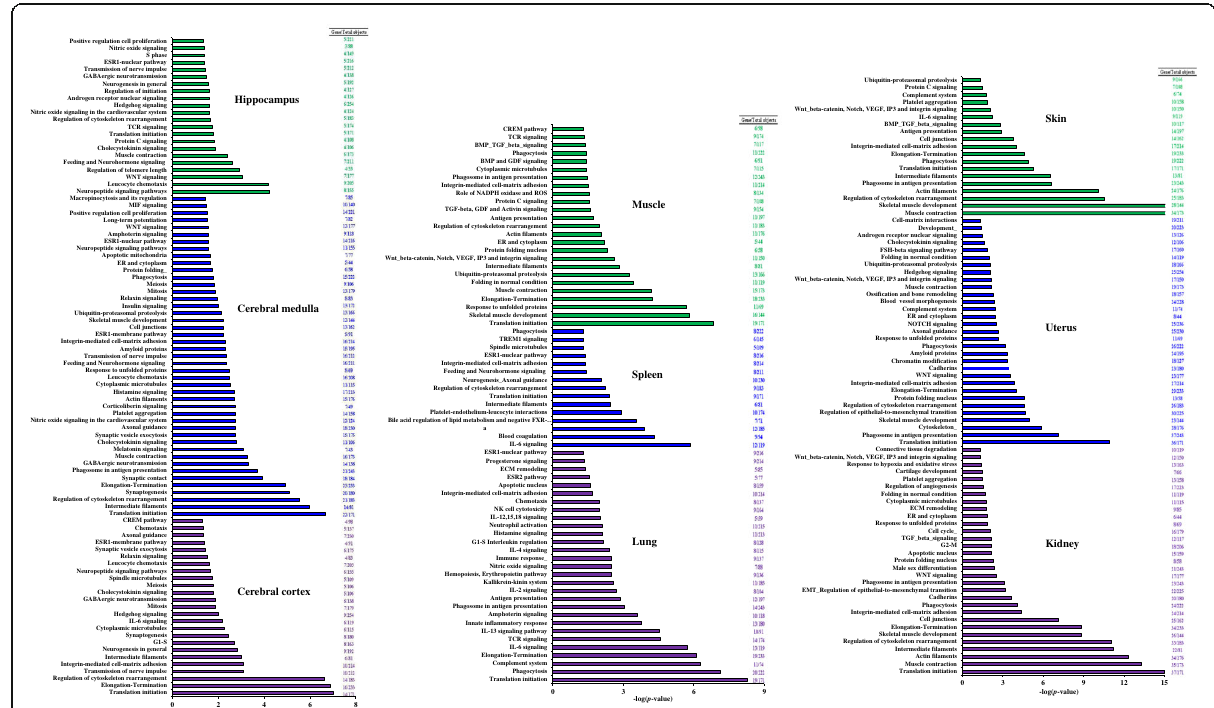
Fig. 4 List of process networks regulated by EA stimulation at ST36 acupoint in various organs. Genes with fold changes ≥ 1.5 or ≤ − 1.5 were selected for the generation of process networks using MetaCore Analytical suit. Data are presented as -log( p -value). The number of affected genes and total objects in each process network is shown on the right